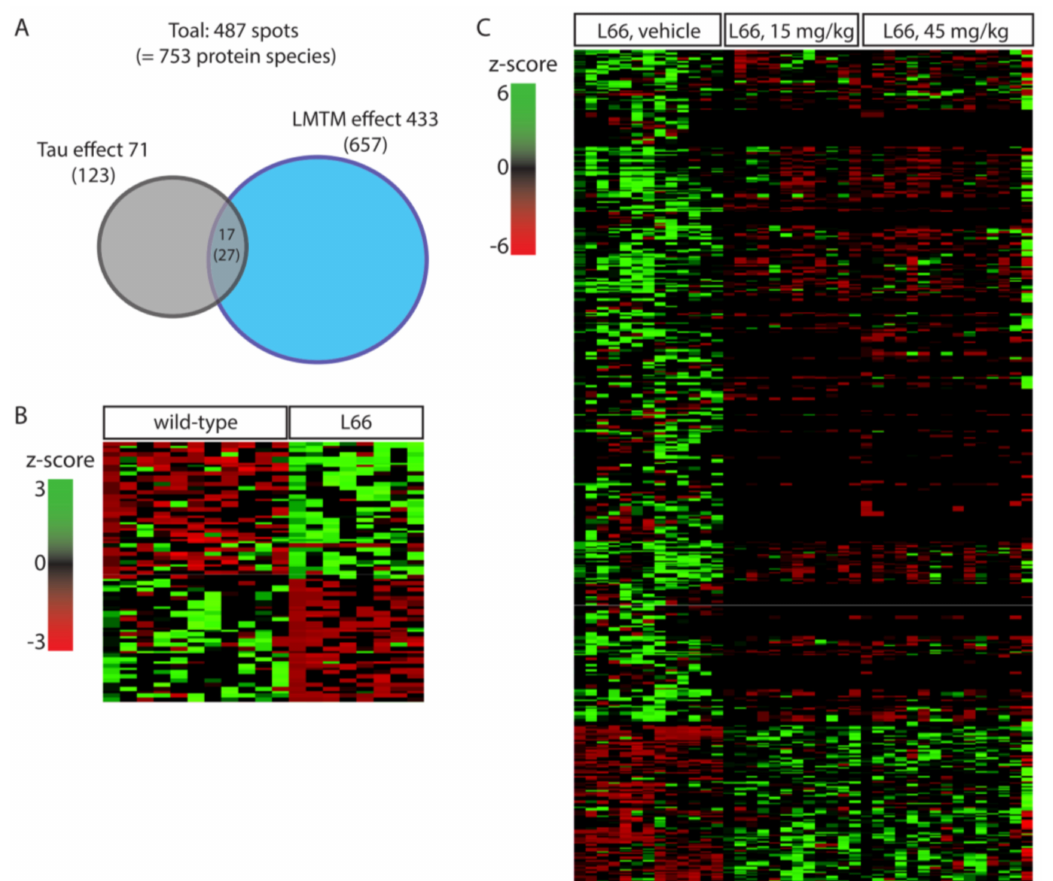
Figure 4. Spots and protein species differentially abundant between wild-type and L66 mice and regulated by LMTM. ( A ) Venn diagram with overview of regulated proteins showing 71 spots (123 protein species) with different expression between genotypes and 433 spots (657 protein species) regulated by LMTM (15 and 45 mg/kg). Seventeen spots (27 protein species) were common to both analyses. ( B ) Heatmap for protein species density in L66 compared to wild-type control mice. ( C ) Heatmap for protein species density in LMTM-treated L66 mice compared to vehicle-treated L66